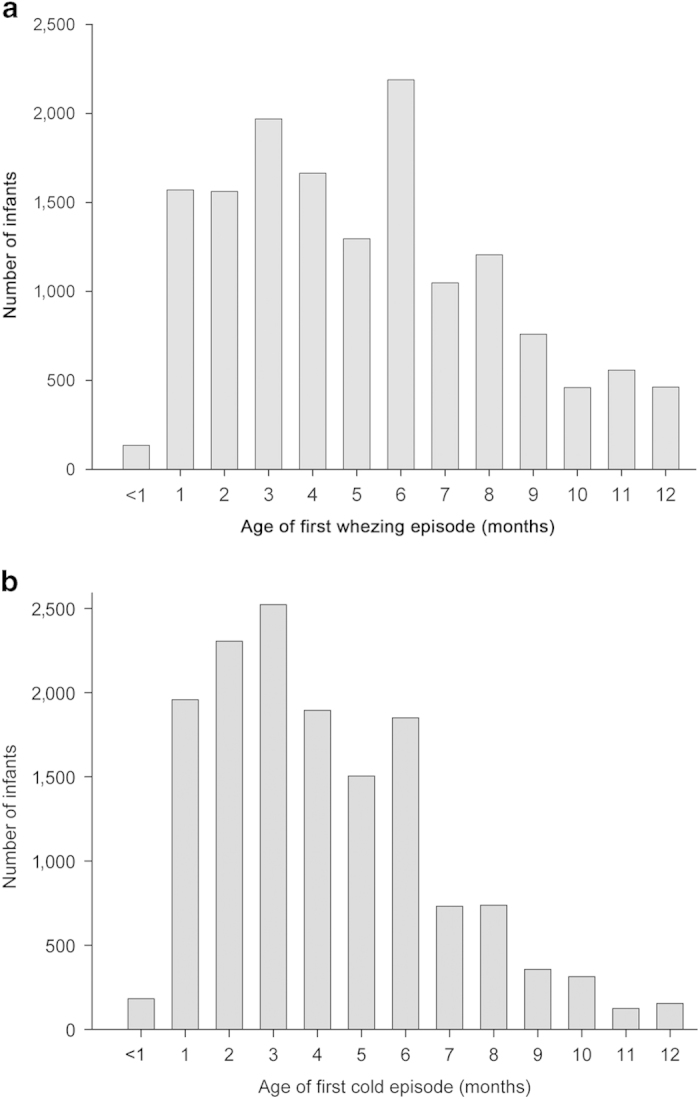
(a) Age (months) at which infants had the first episode of wheeze (absolute numbers). (b) Age (months) at which infants had the first episode of cold (absolute numbers).